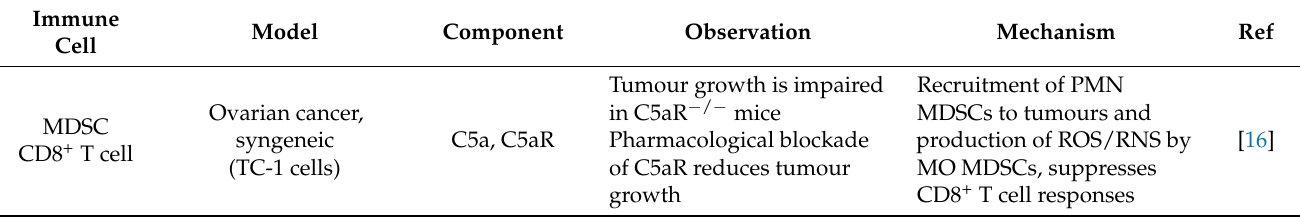
Table 2. Functional effects of complement on immune cells which promote tumour growth in mouse models. Immune